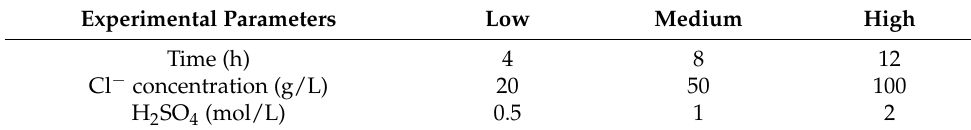
Table 3. Experimental parameters used in statistical analysis [13].